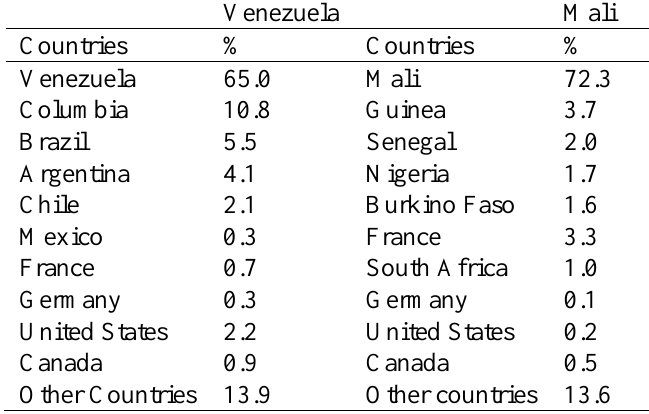
Table 3: Polycentric WSFs 2006 by nationality of participant (in